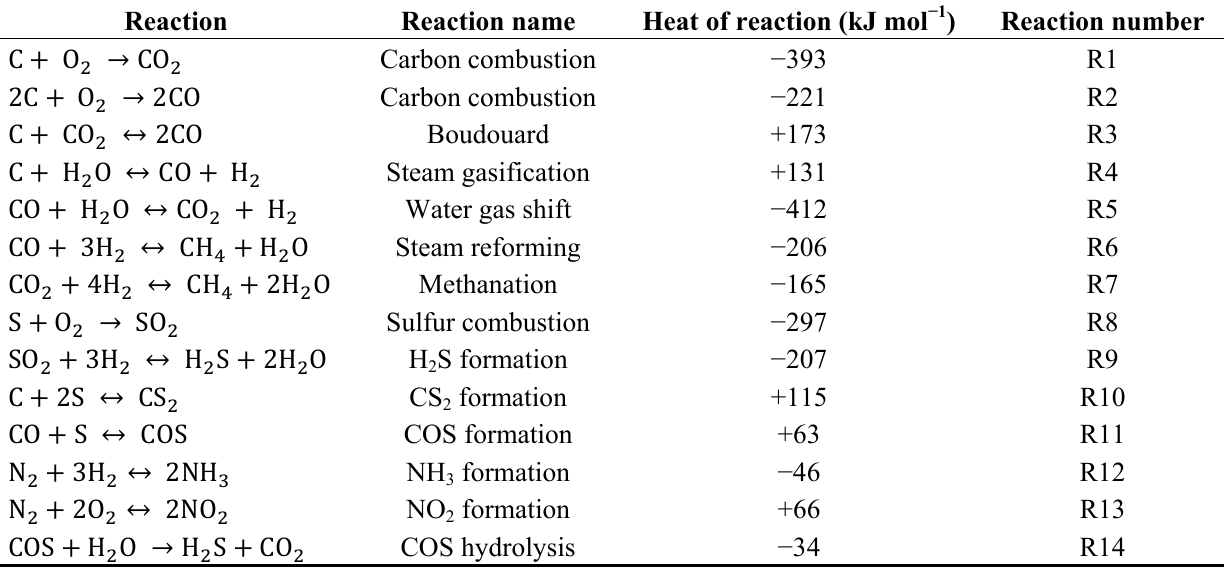
Table 4. Main process